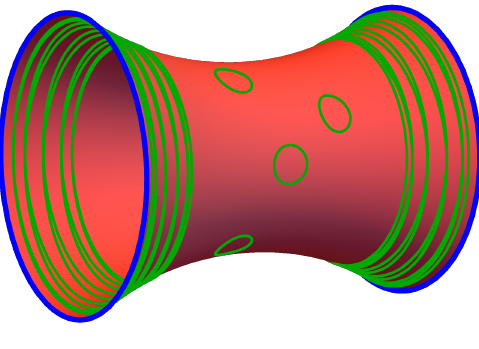
Figure 3 . A typical string configuration for string theory on the wormhole geometry.The small strings in the middle are spheres, whereas the winding strings close to the boundary are genus g ≥ 1